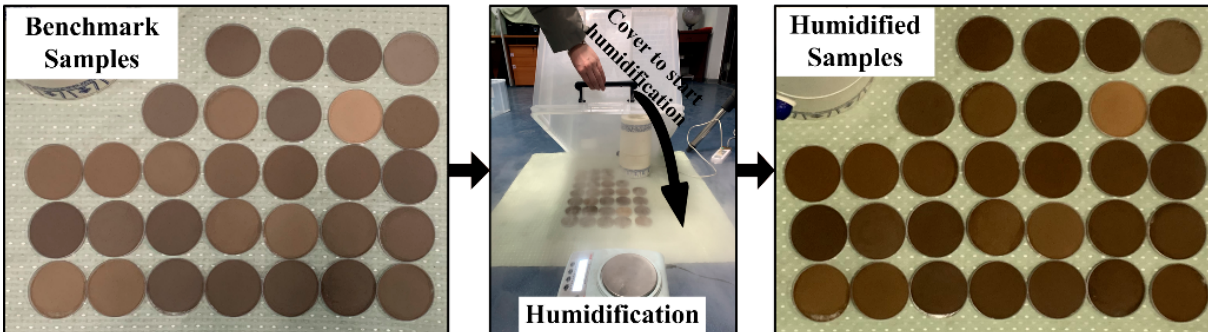
Figure 5. The humidification box and samples.